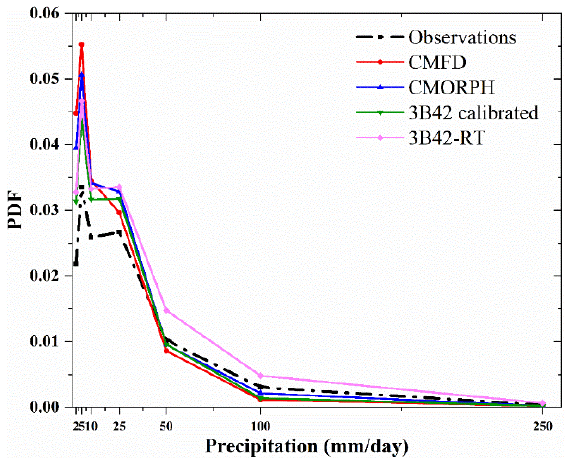
Figure 9. Probability density function (PDF) of daily precipitation during the study period derived from ground observations, and satellite precipitation products.